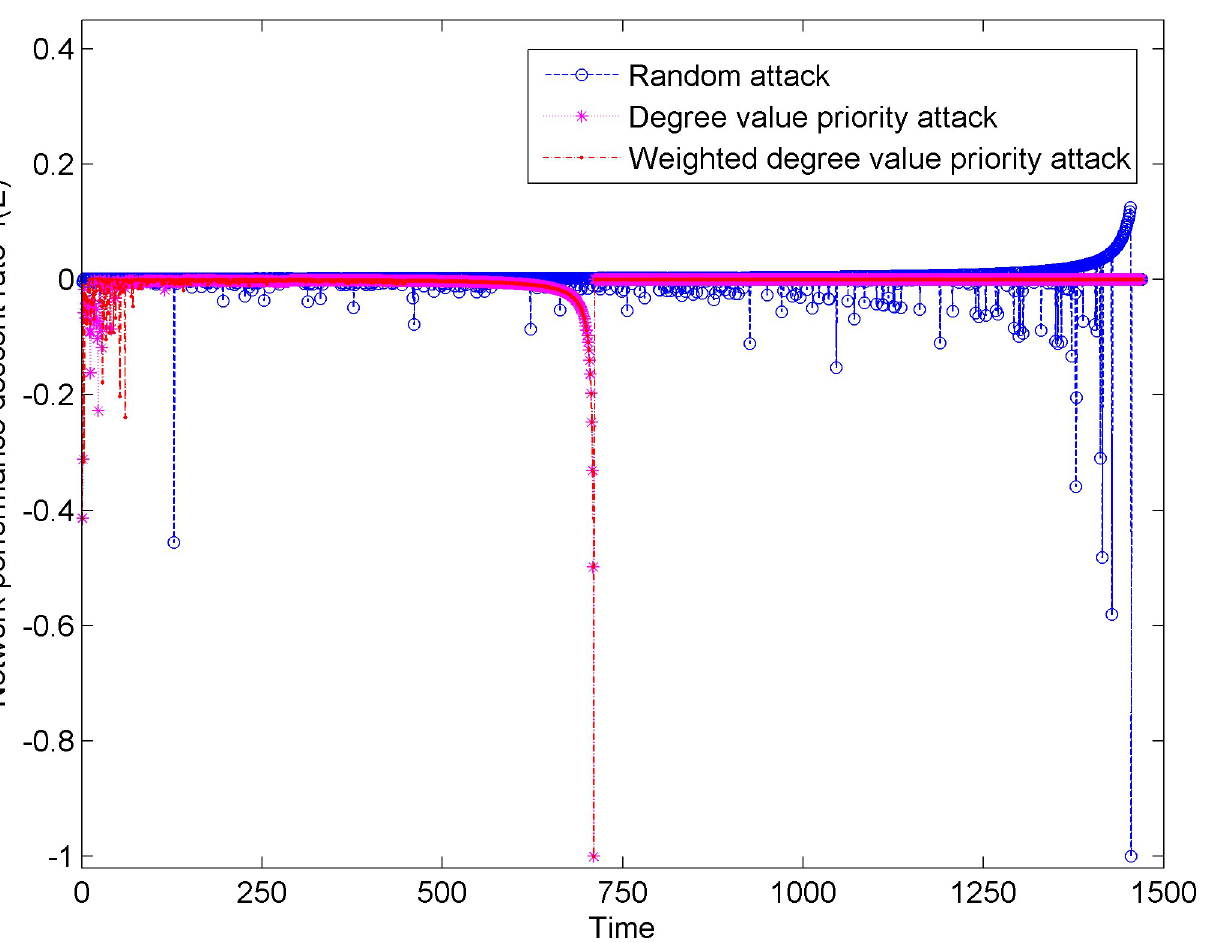
Fig 5. Changes of network performance descent rate under three types of